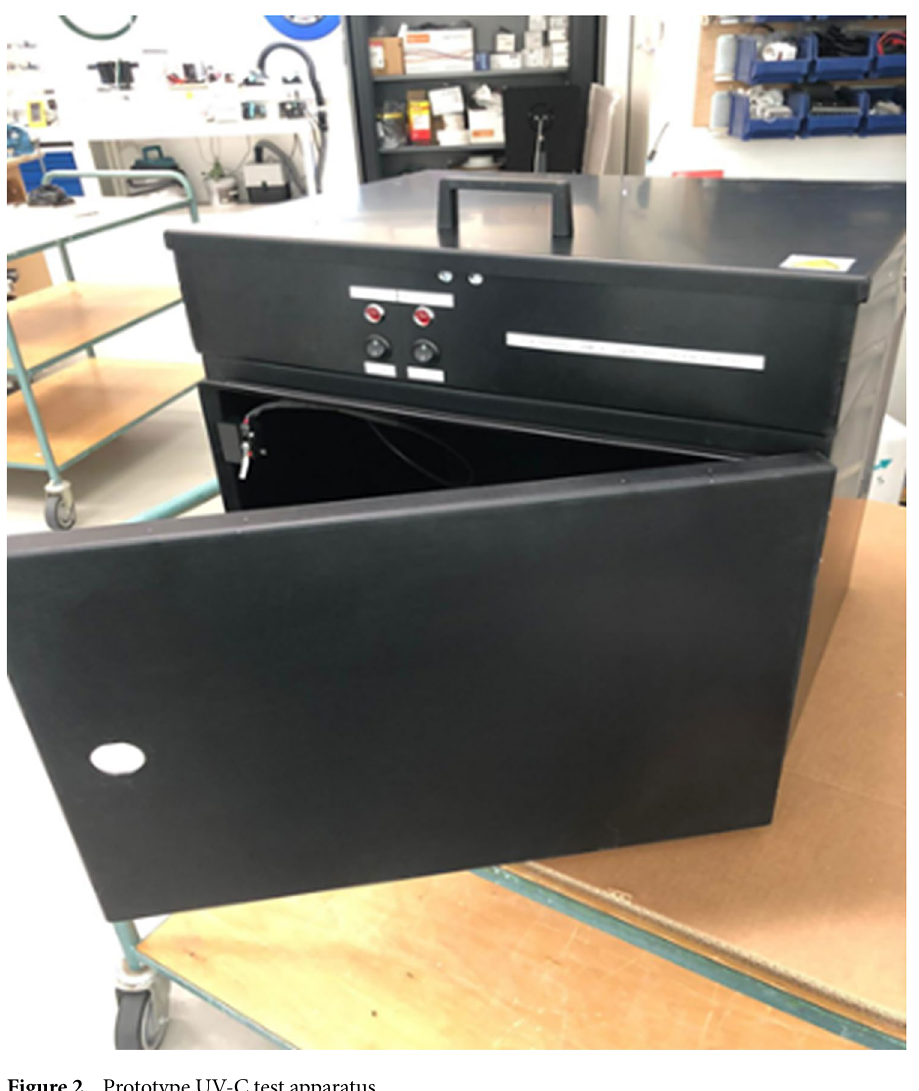
Figure 2. Prototype UV-C test apparatus.